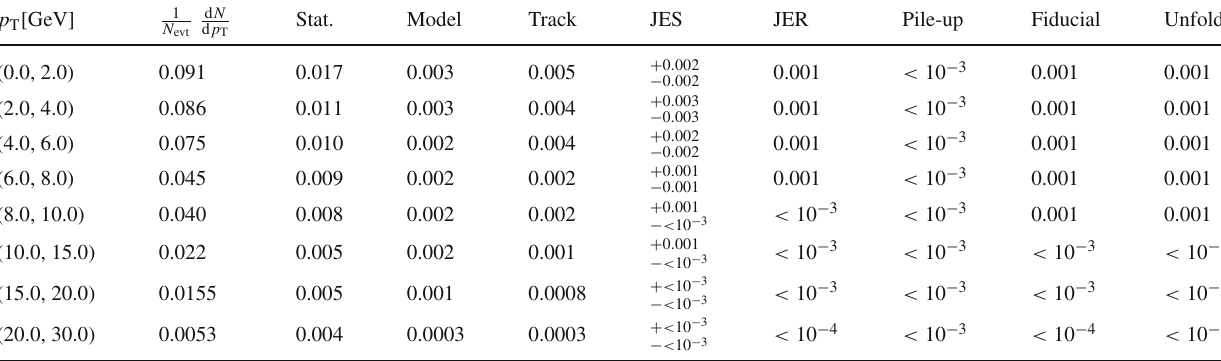
associated with b -jets, and including invisible decays, along S